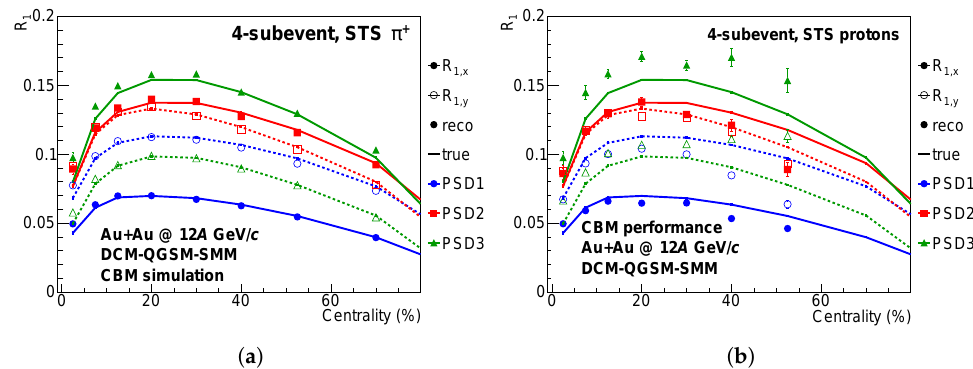
Figure 4. Resolution correction factors for PSD subevents calculated with the 4-subevent method using the auxiliary STS subevent from ( a ) positively charged pions and ( b ) protons. The lines show the true values of the resoltuion obtained using reaction plane angle from event